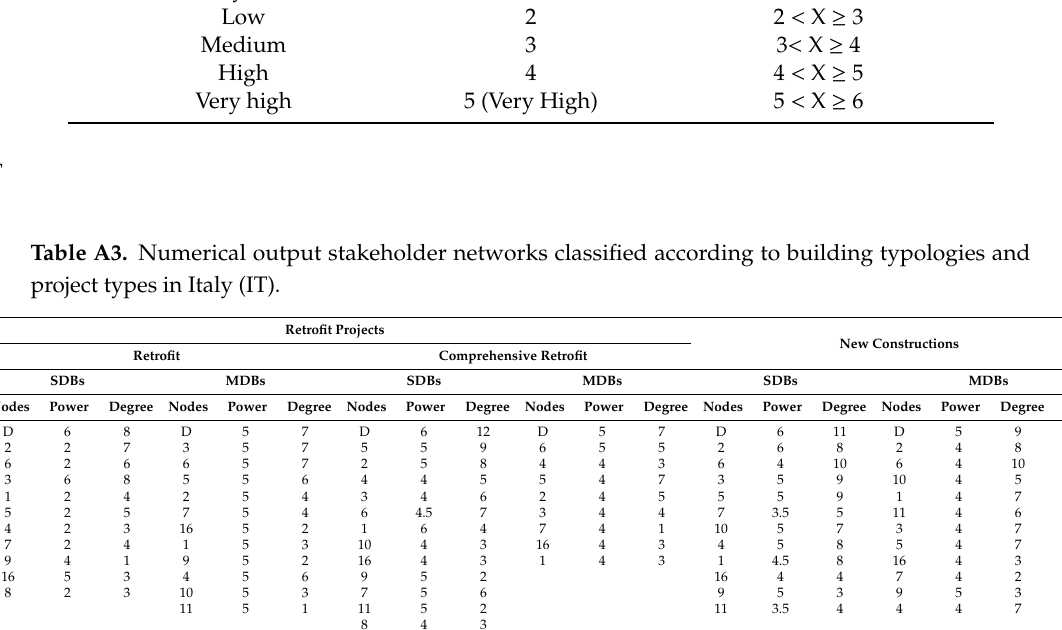
Table A2. Legend to read the numerical outputs of the networks. Level of Communication Likert Scale Numerical Interpretation No power